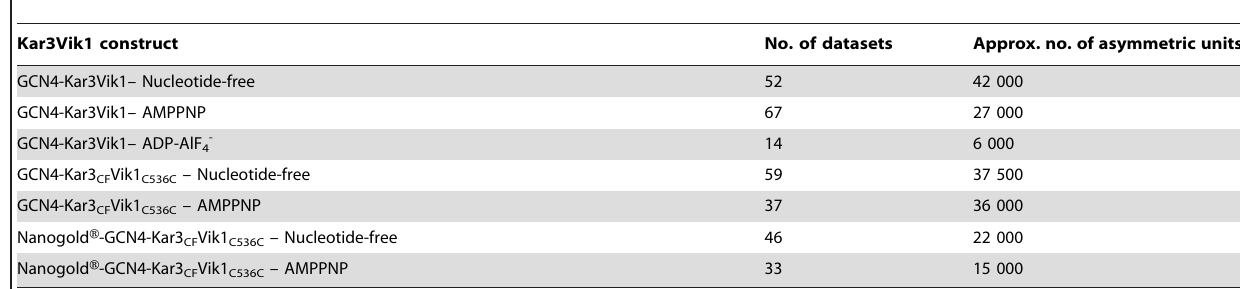
Table 1. Kar3Vik1 constructs and approximate number of asymmetric units included in cryo-EM helical averages.